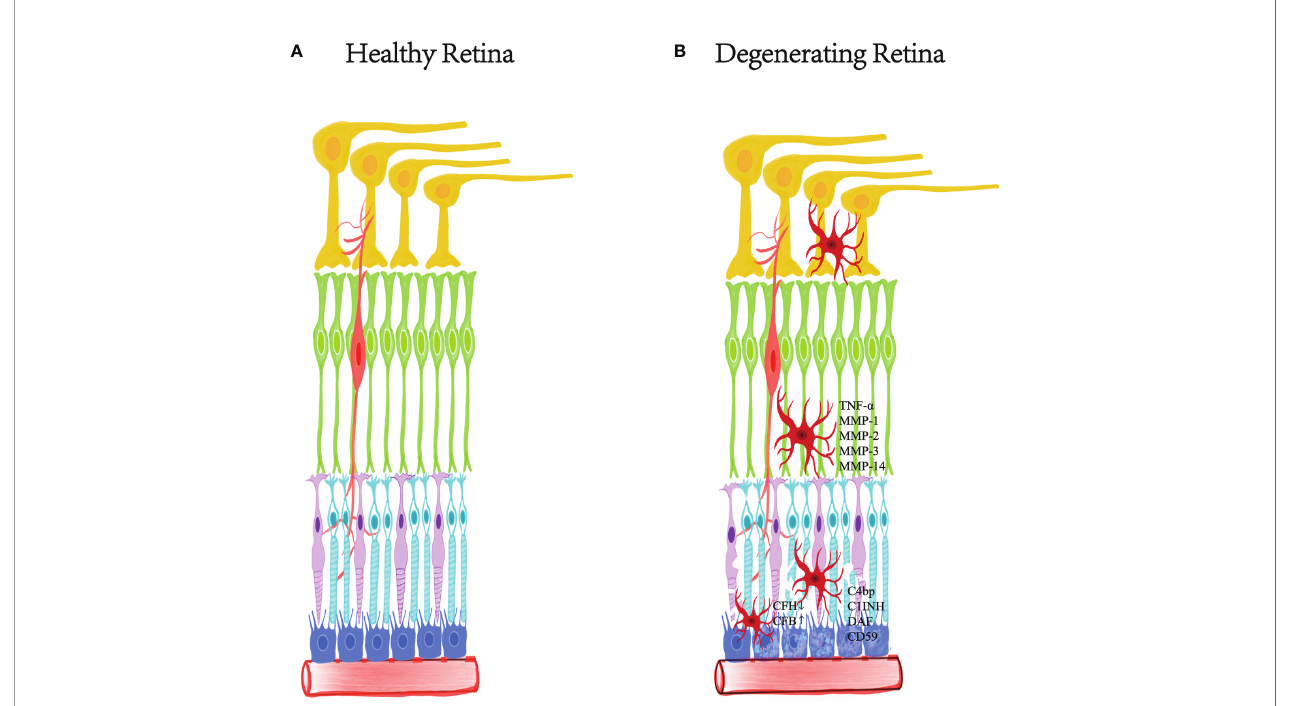
FIGURE 2 | The relationship between in fl ammation and degenerative retina. Degenerative retinal diseases are characterized by the destruction of retinal homeostasis and mild chronic in fl ammation. In fl ammatory factors released by microglia recruited in the injured layer play a crucial role in pathological changes, expressing TNF- a and several metalloproteinases, including MMP-1, MMP-2, MMP-3 and MMP- 14. Microglia, retinal pigment epithelial cells and neurons in the retina express various complements and complement regulators. The degenerative retina reduces the expression of complement inhibitor CFH, while enhancing the expression of CFB in RPE cells. In addition, changes in the immunosuppressive microenvironment can interfere with RPE and microglia to produce various complement regulators (C4bp, C1INH, DAF and CD59). (A) The healthy retinal layered morphology. (B) The damaged retina under degenerative